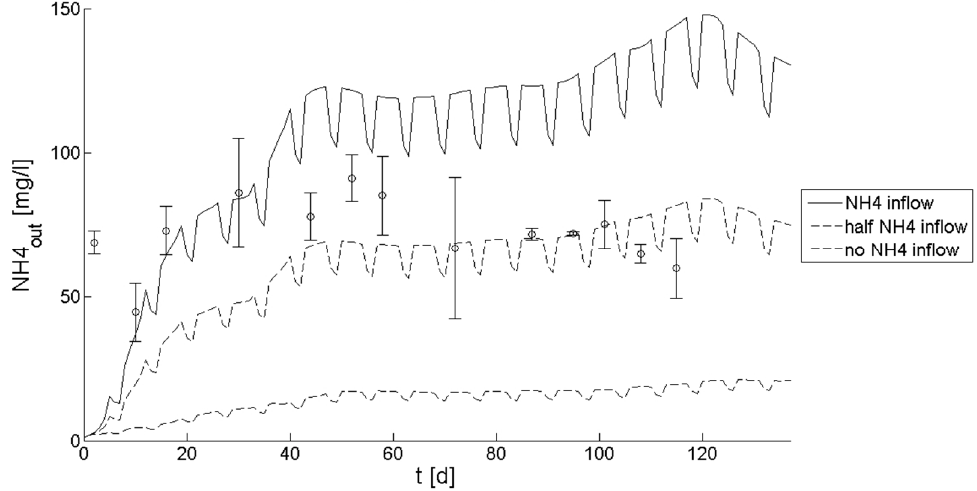
Figure 5. Influence of inflow NH4 ‐ N concentrations on effluent NH4 ‐ N concentrations of a HF wetland (adapted from [6]).